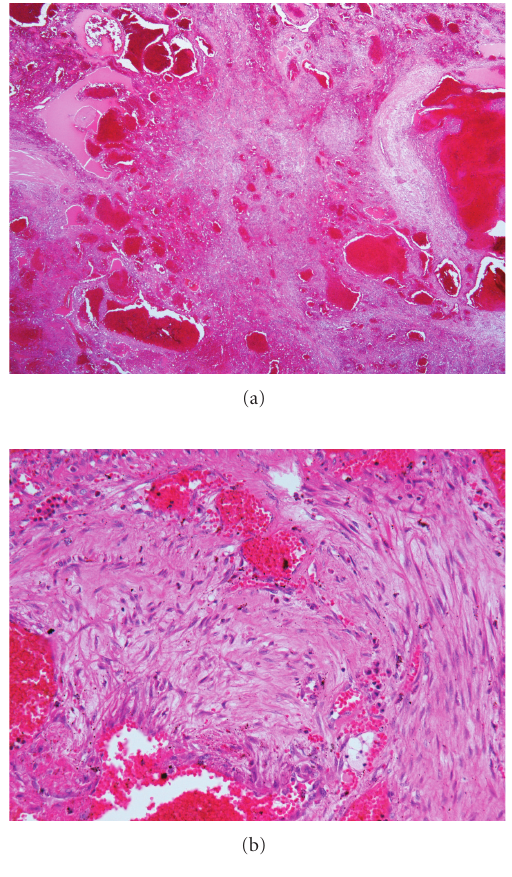
Figure 5: Microscopic findings of the spindle cell hemangioen- dothelioma. (a) Low-power view of the lesion showing cavernous blood vessels filled partly or completely with erythrocytes or thrombus admixed with cellular zones (hematoxylin-eosin, original magnification × 40). (b) High-power view of juxtaposition of the cavernous and cellular areas illustrating blood-filled dilated vessels lined by flattened endothelial cells and spindle-shaped cellular components. There is no evidence of abnormal mitotic activity or nuclear atypia in spindled cells (hematoxylin-eosin, original magnification × 100).